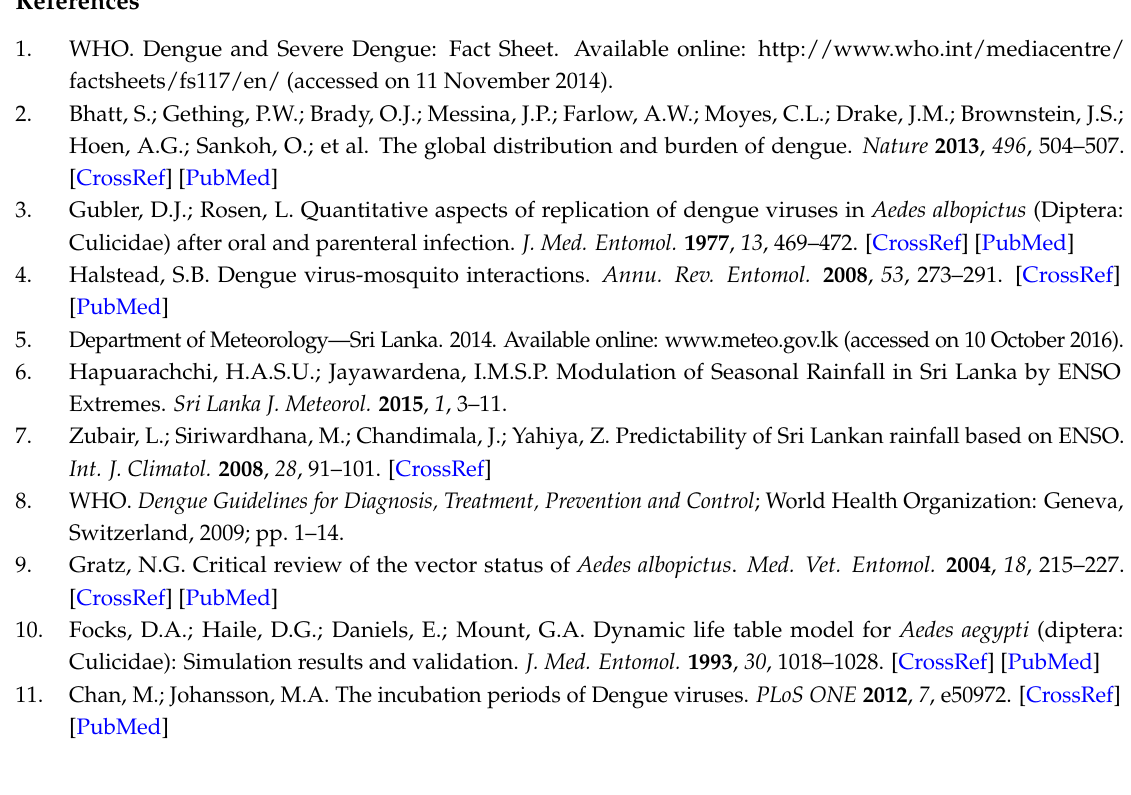
Table S1: Quasi AIC changes associated with inclusion/exclusion of weather variables, Figure S1: Residual Diagnostic Plots of the model, Table S2: Cochran Q test and I 2 statistic for second stage multivariate model based on different exposure levels of weekly cumulative rainfall, Table S3: Cochran Q test and I 2 statistic for second stage multivariate model based on different exposure levels of weekly mean temperature, Table S4: Cochran Q test and I 2 statistic for second stage multivariate model for overall cumulative association in 10 MOH divisions for ONI for each variable, Figure S2: Division specific effect of rainfall on the relative risk of dengue in 10 MOH divisions in Kalutara district showing divisional heterogeneity, Figure S3: Division specific effect of temperature on relative risk of dengue in MOH divisions in Kalutara district, Figure S4: Relative homogeneity of daytime temperatures across MOH Divisions within Kalutara during the study period, Figure S5: Relative homogeneity of nighttime temperatures across MOH Divisions within Kalutara during the study